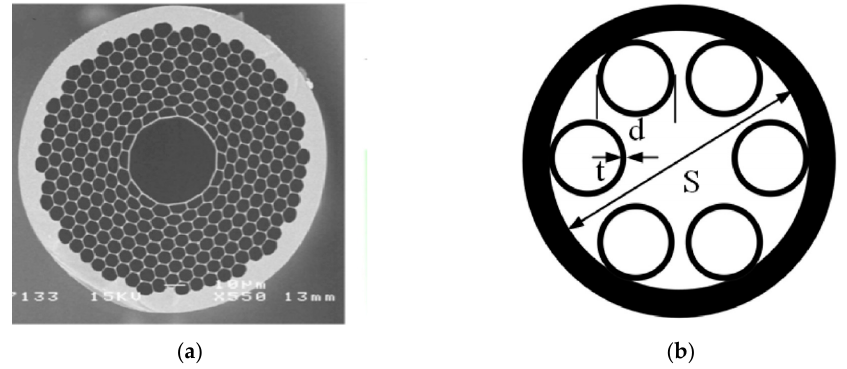
Figure 2. ( a ) Cross-section of HCPBGF. Reprinted with permission from [29]; © The Optical Society. ( b ) Cross-section of HCARF. Reprinted from [30], copyright (2019), with permission from Elsevier.